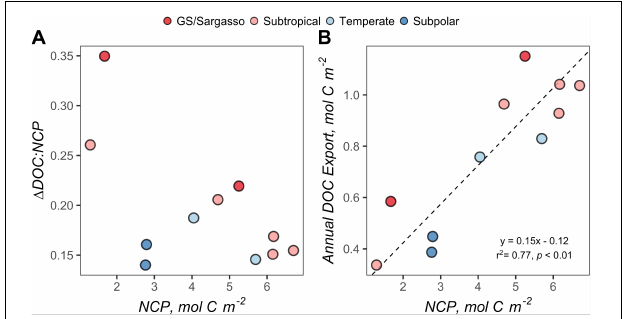
FIGURE 6 | (A) Variability of (cid:49) DOC:NCP over the range of seasonal net community production ( NCP) . (B) Standard major axis model II regressions for NCP and annual DOC export. Each point represents estimates for a station during the early autumn cruise. Points are filled by the subregional classification of the station as described in Figure 1 . NCP and (cid:49) DOC:NCP represent values integrated to 100 m. Annual DOC export represents values integrated from 100 m to the maximum mixed layer depth (see Figure 3B